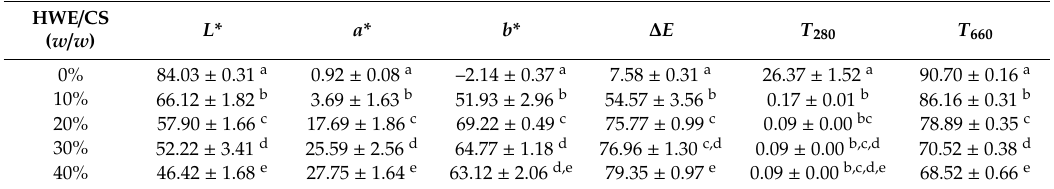
Table 1. Summary of the color and optical properties of composite films with di ff erent concentrations of HWE (BT / CS = 5%).